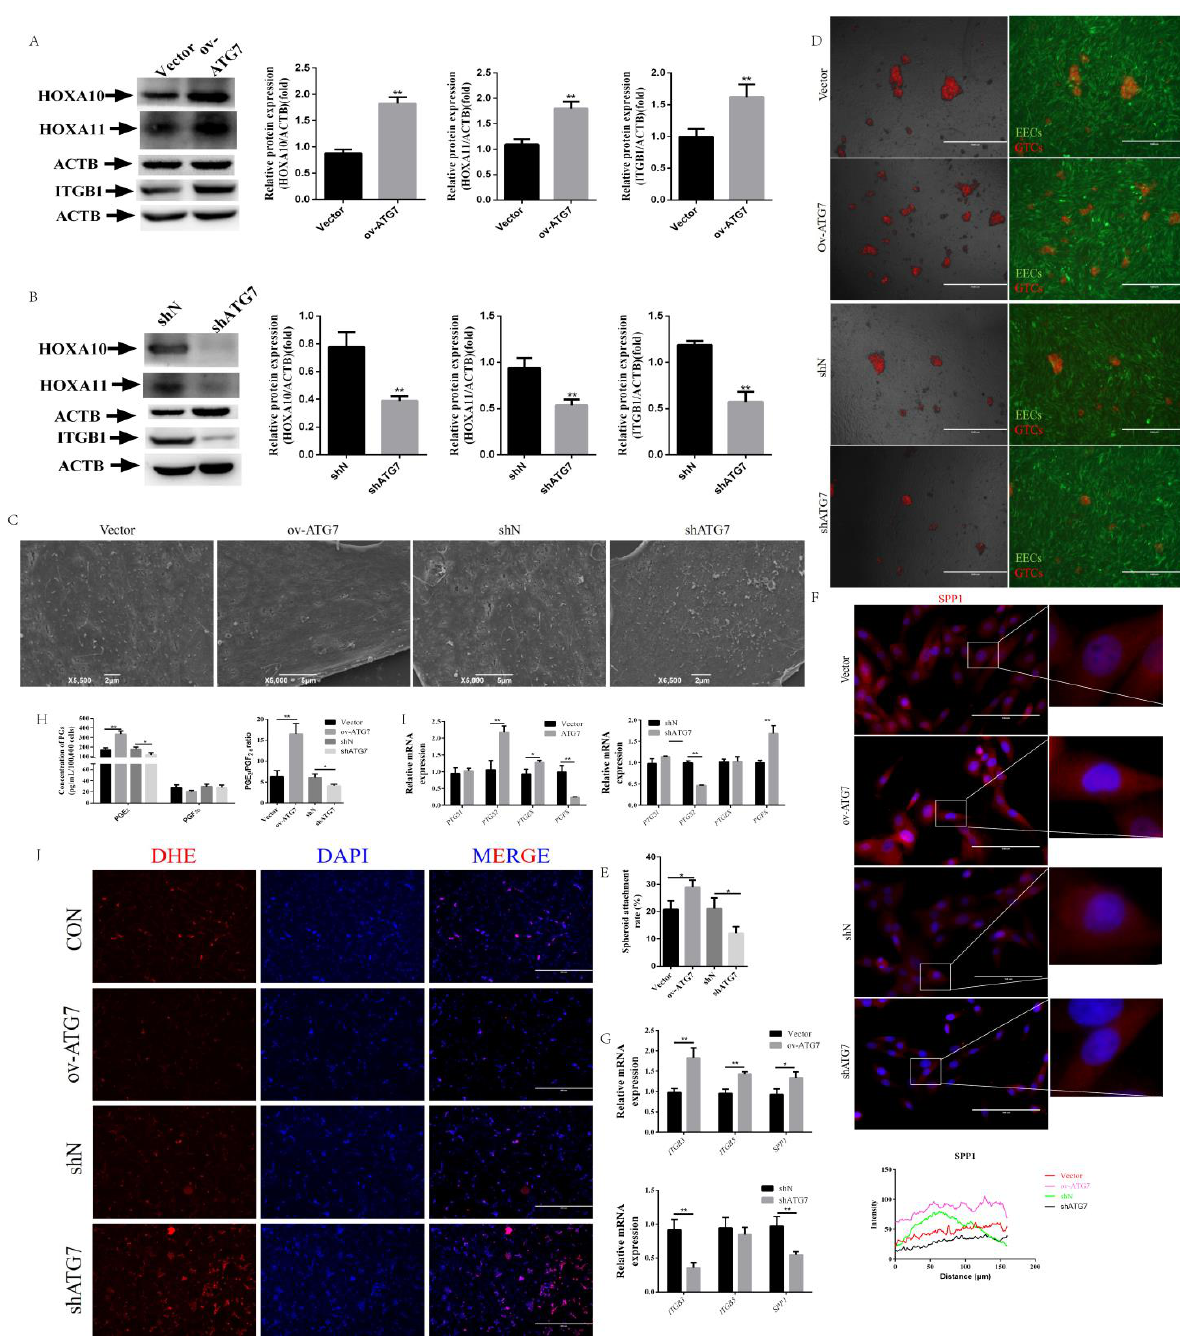
Figure 5. Effect of ATG7 on endometrial receptivity in shCRIM1 EECs. ( A ) and ( B ) The shCRIM1 EECs were infected with the Vector, ov-ATG7, shN or shATG7 lentivirus for 48 h under P 4 , E 2 and IFN-τ treatment. Total proteins from the Vector, ov-ATG7, shN and shATG7 groups were subjected to Western blotting. ( C ) The Vector, ov-ATG7, shN and shATG7 groups were treated with P 4 , E 2 and IFN-τ for 12 h. The EECs were fixed and processed for SEM analysis. ( D ) and ( E ) GTC sphe- roids were prepared and the spheroid attachment rate was measured. Representative images of three independent exper- iments are shown. Scale bar = 1000 μm. ( F ) Fluorescence microscopy images of SPP1 expression in EECs and curves of fluorescence intensity. Representative images of three independent experiments are shown. Scale bar = 100 μm. ( G ) The